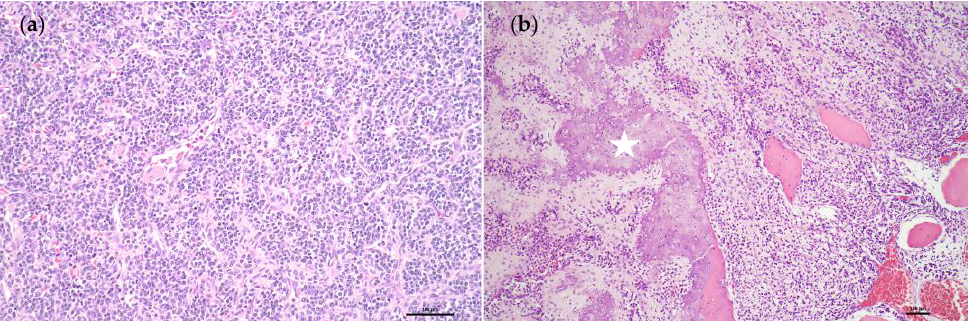
Figure 2. The immunohistochemistry stain of the pancreatic mass. The histological result revealed small blue round and spindle-shaped mesenchymal cells (( a ), 200×). In addition, the picture shows the islets of highly differentiated cartilage (indicated by a white star) transited abruptly from the surrounding blue round cells (( b ), 100×).